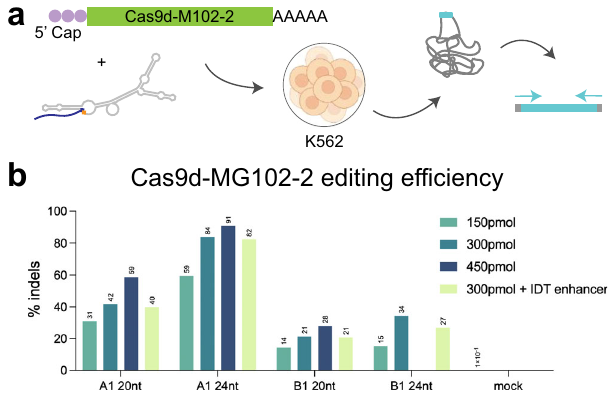
Fig.3|Cas9d-MG102-2isahighlyactivenucleaseinhumancells.a Flowdiagram ofCas9d-MG102-2mRNAdeliverytoK562cells.ThesgRNAwitha20or24bpguide and the human codon-optimized nuclease mRNA were nucleofected into cells, genomicDNAwasextractedandeditingattheexpectedtargetsitewasdetermined via amplicon NGS. b Nuclease activity was evaluated for the Cas9d-MG102-2 nucleaseattwotargetingsitesintheTRAClocus(guidesA1andB1)withincreasing concentrations of sgRNA (150, 300, and 450pmol/reaction). The mock control represents background editing levels at the target region in the absence of mRNA and